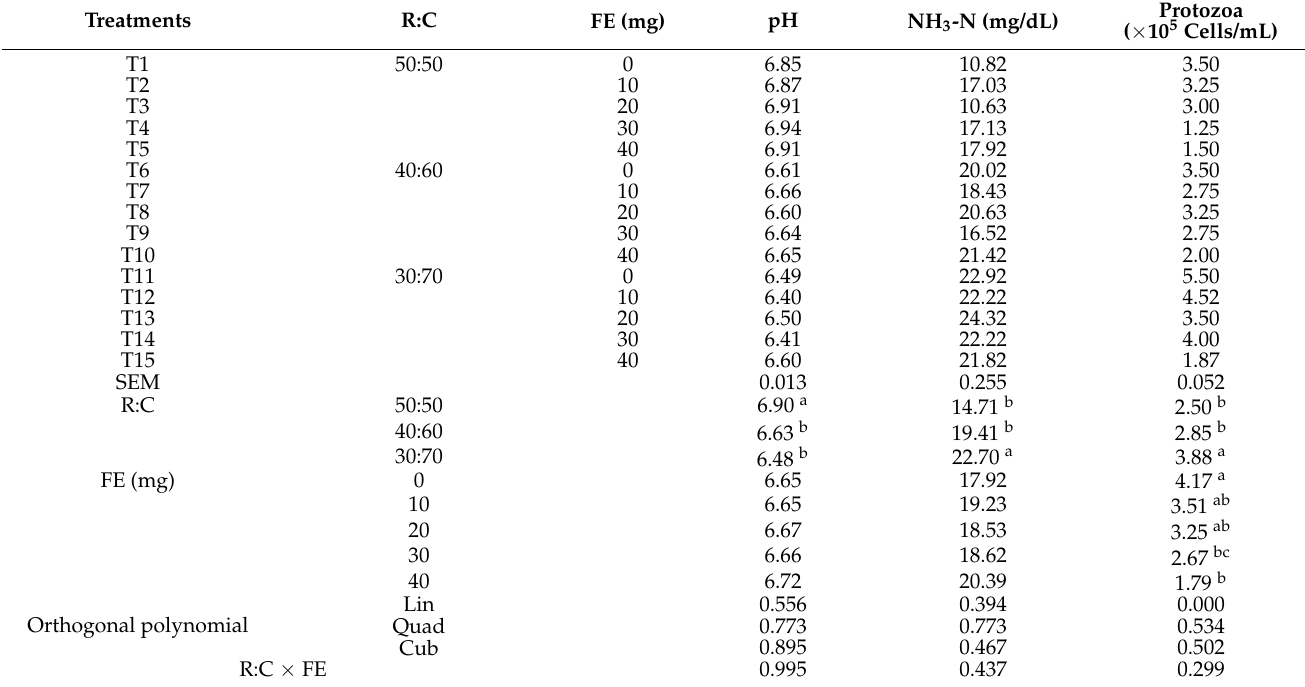
Table 5. Effect of R:C ratios and flavonoid extract levels on ruminal pH, ammonia nitrogen (NH 3 -N), and protozoal population.